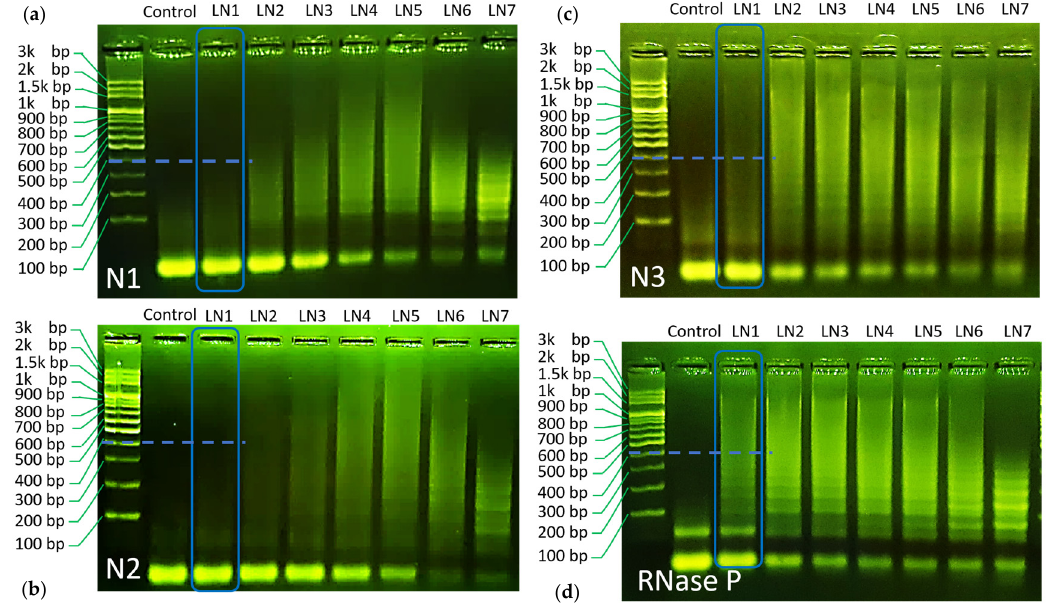
Figure 2. ( a ) Gel electrophoresis result for the proposed N1 HCR. ( b ) Gel electrophoresis result for the proposed N2 HCR. ( c ) Gel electrophoresis result for the proposed N3 HCR. ( d ) Electrophoresis result for the proposed RNase P HCR.